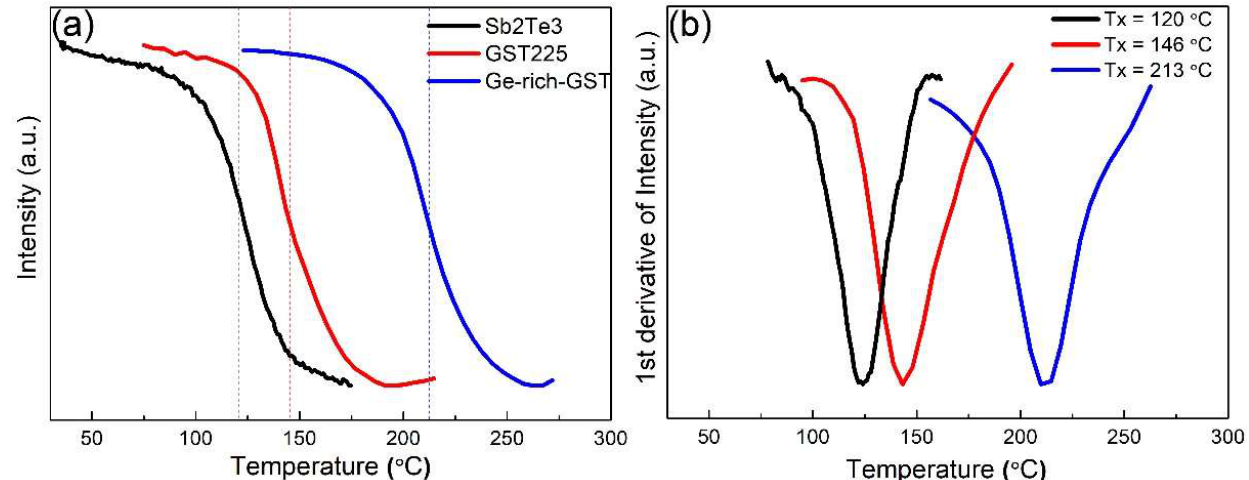
Figure 3. ( a ) Crystallization curves from dynamic ellipsometry measurements. Measurements of Sb 2 Te 3 and GST225 are also plotted, in addition to the Ge-rich GST thin film, for better comparison. An abrupt change in intensity indicates a phase transformation upon heating. ( b ) The first derivative of the intensity from the dynamic ellipsometry measurement indicates exact crystallization temperature. A higher Tx value is observed for Ge-rich GST samples.